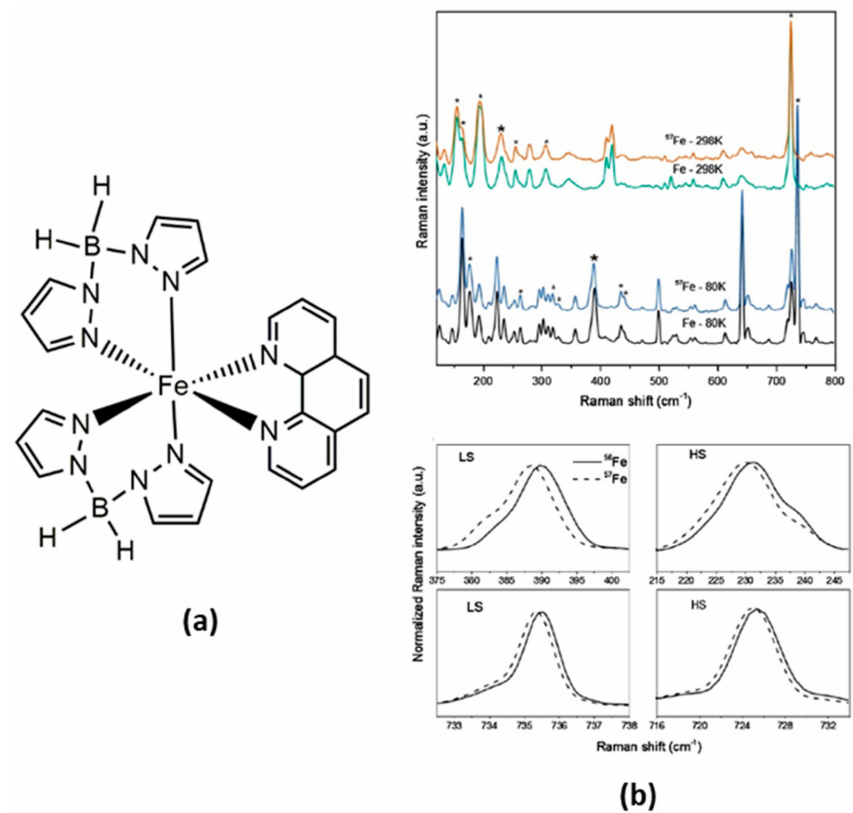
Figure 4. ( a ) Structural drawing of the complexes [Fe(H 2 B(pz) 2 ) 2 (phen)] ( 4 ). ( b ) Raman spectra of the HS and LS states for the Fe and 57 Fe samples (up); * indicate the modes with significant isotopic shift and magnified Raman spectral window displaying isotopic shifts (down). ( b ) is reprinted with permission from ref. [73], copyright 2016,